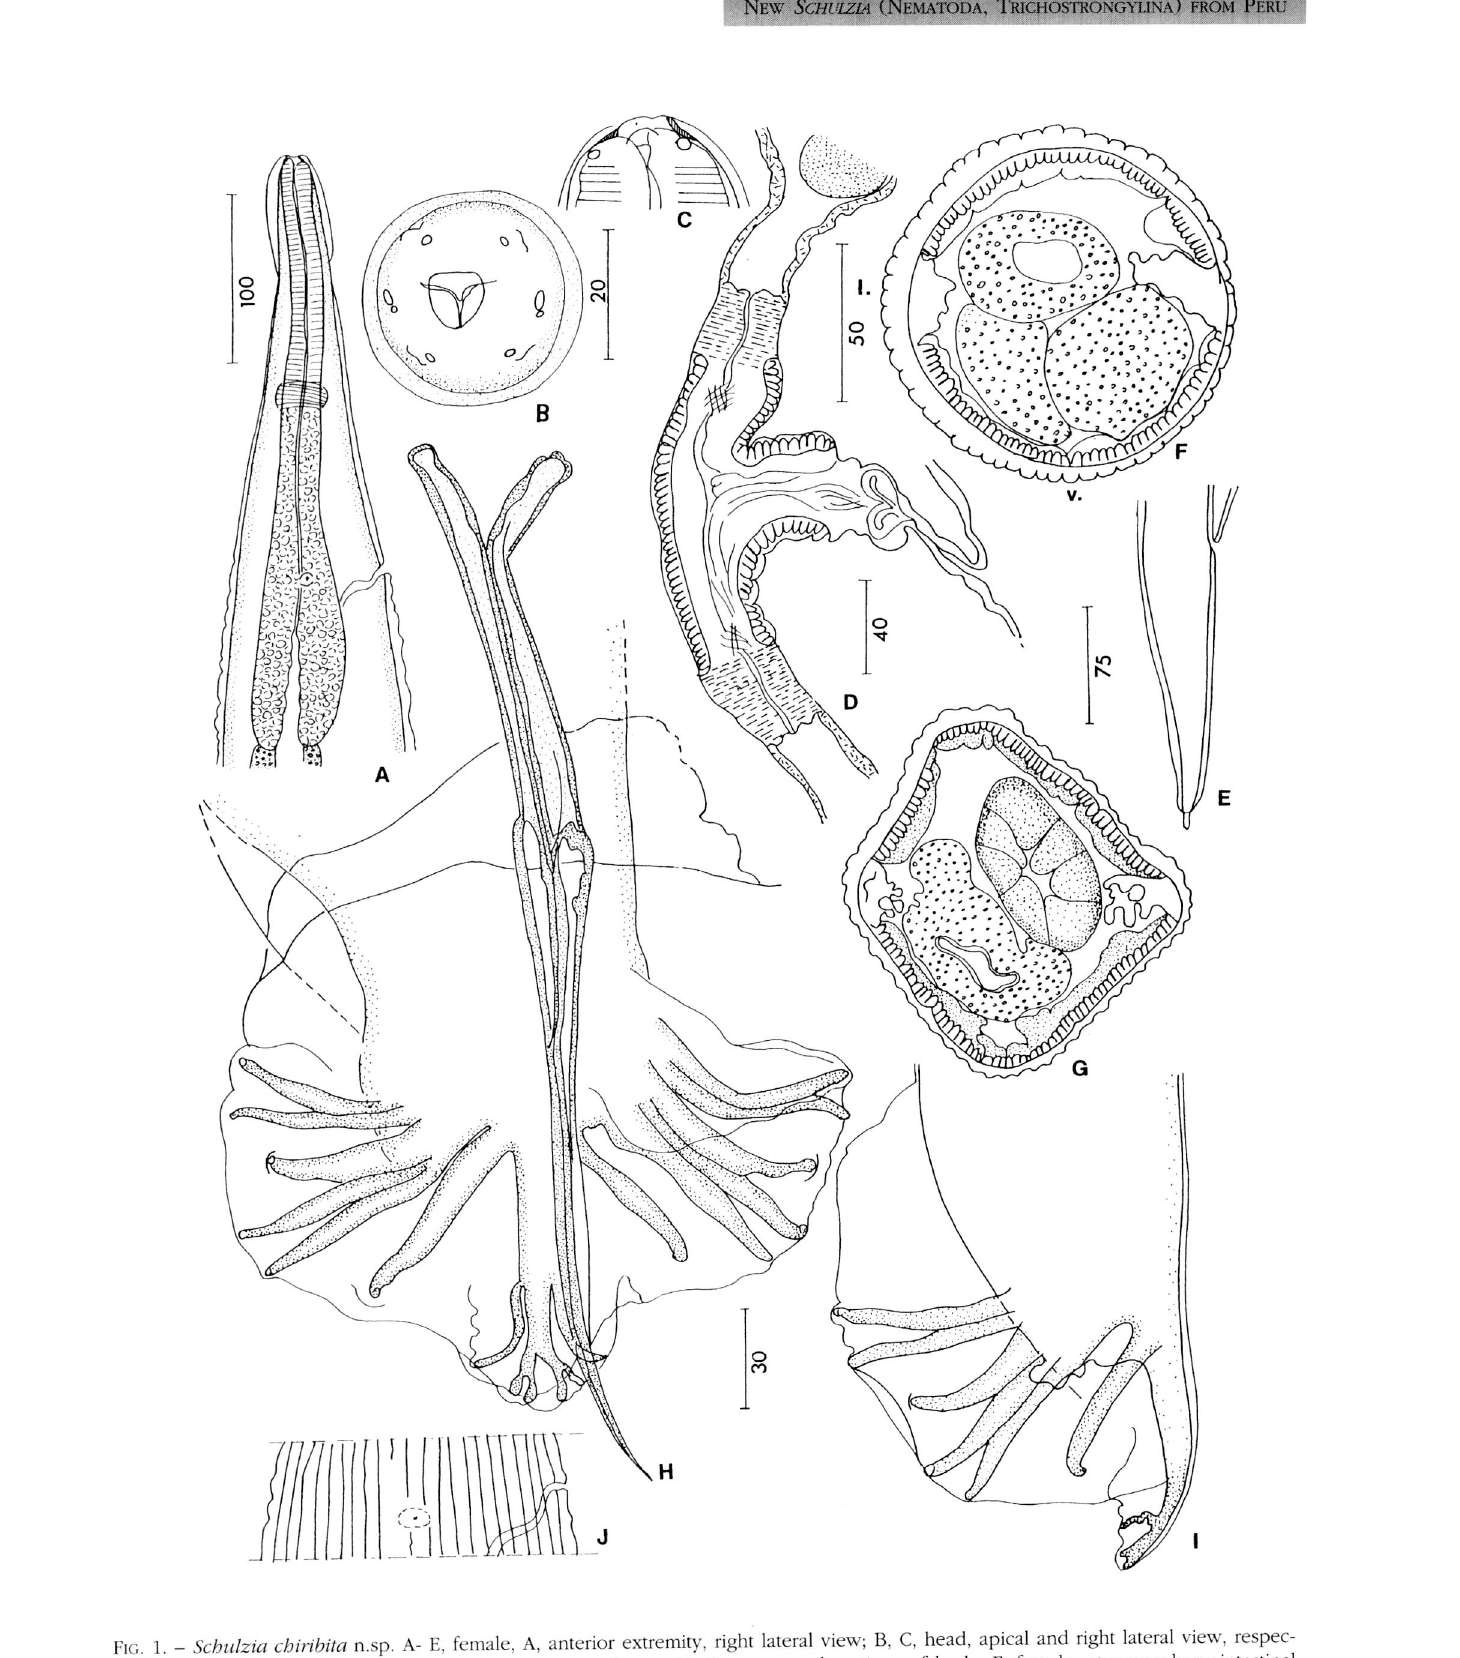
FIG 1 - Schulzia chiribita n.sp. A- E. female, A, anterior extremity, right lateral view; B, C, head, apical and right lateral view, respec tively; D, ovejector, right lateral view; E, tail, right lateral view; F, G, transversal sections of body, F, female, at oesopahago-intestinal junction, G, male, at mid-body ; H-J, male, H, I, caudal bursa, H, ventral view, I, lateral view; J, detail of excretory pore and deirid, right lateral